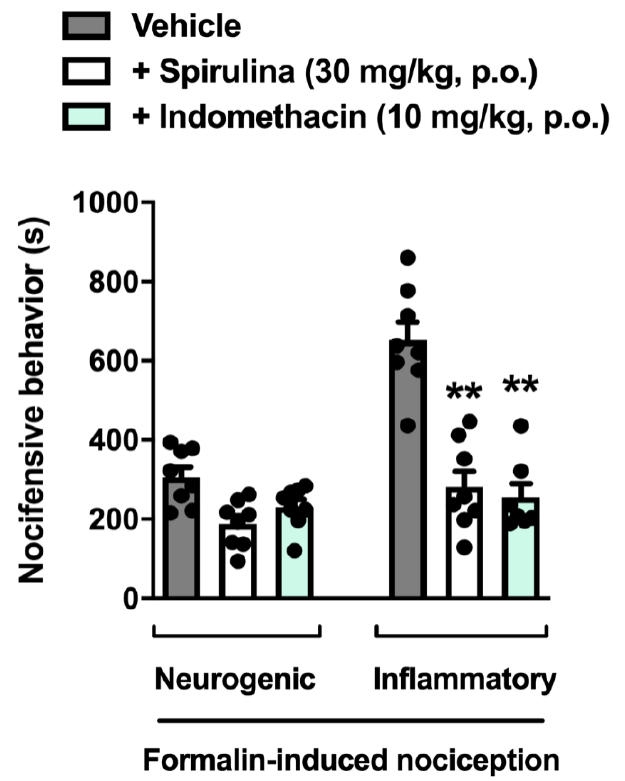
Figure 3. Effect of Spirulina on nocifensive behavior induced by formalin in mice during the first (neurogenic) and second (inflammatory) phases. Each column represents the mean ± SEM of 7–8 animals/group, with a black dot showing individual mice. Asterisks indicate the levels of significance compared to the vehicle (control) group. ** p < 0.001 using one-way